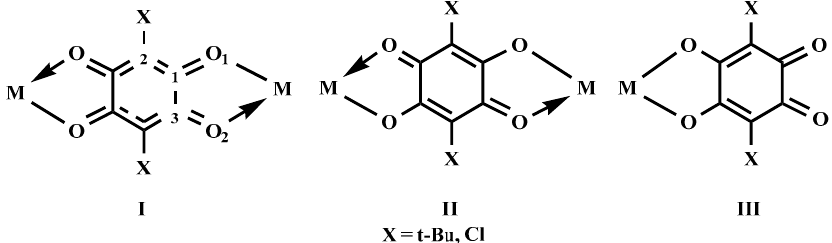
Figure 7. The voids in crystal packing of 2 along the ( 001 ) vector ( a ) and 3 along the ( 100 ) vector ( b ). The voids volumes were computed with probe radius 1.2 Å and approx. grid spacing 0.7 Å. Color code: the outer side of the voids, red; the inner side, yellow.